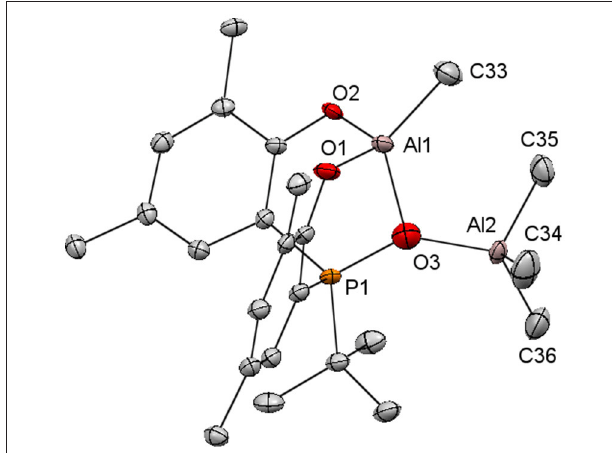
FIGURE 3 | Molecular structure of [ 3a ]AlMe • AlMe 3 with thermal ellipsoids drawn at the 35% probability level. All hydrogen atoms and the methyl groups in arylated tert -butyls are omitted for clarity. Selected bond distances (Å) and angles (deg): Al(1)-O(2) 1.749(3), Al(1)-O(1) 1.764(3), Al(1)-C(33) 1.933(5), FIGURE 4 | Molecular structure of {[ 3a ]Al( µ 2 -OCH 2 Ph)} 2 with thermal